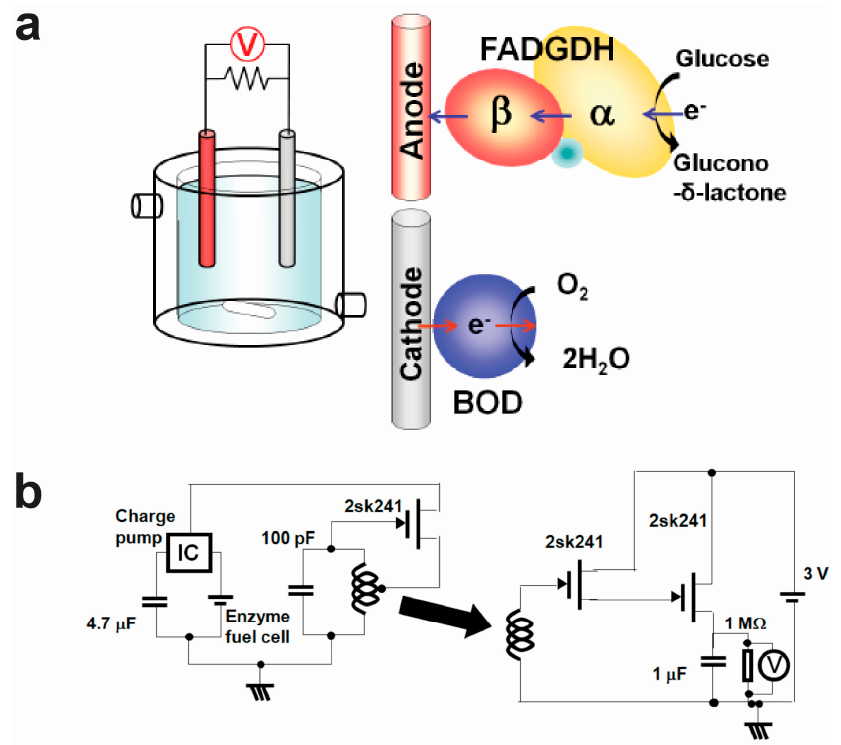
Figure 4. A wireless self-powered bioelectronic sensor, ( a ) a biofuel cell based on a FADGDH complex-based anode and a BOD-based cathode, and ( b ) a bioradio-transmitter circuit for the self-powered wireless sensor. Reprinted with permission from [73]. Copyright (2011) Diabetes Technology Society.